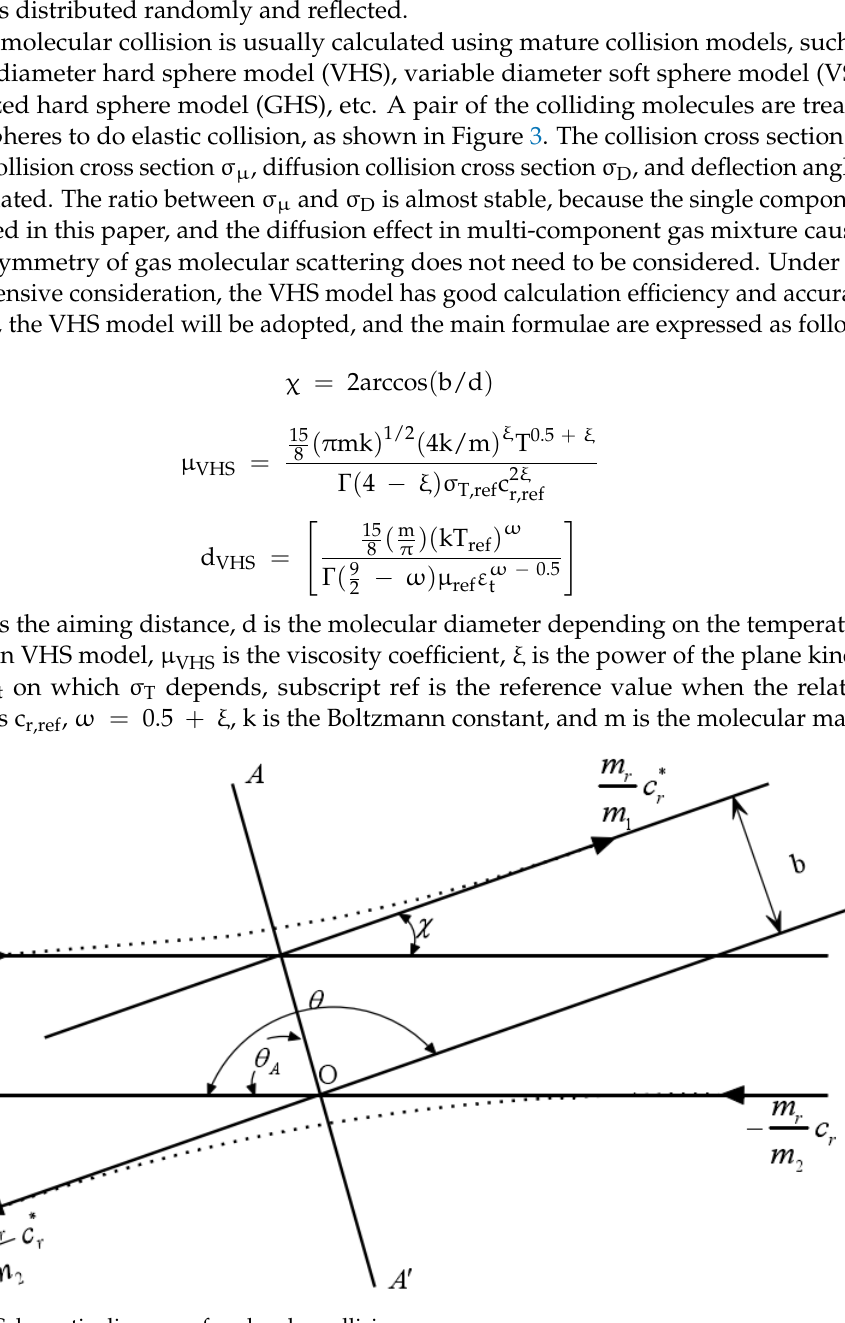
Figure 3. Schematic diagram of molecular collision. The Monte Carlo method is used for statistics of molecular sampling. In order to eliminate the numerical oscillation caused from the randomness, more time steps are taken for analyzing, and the averaged value is used as the corresponding flow state. In this way, the flow field is gradually updated during numerical iteration until convergence is